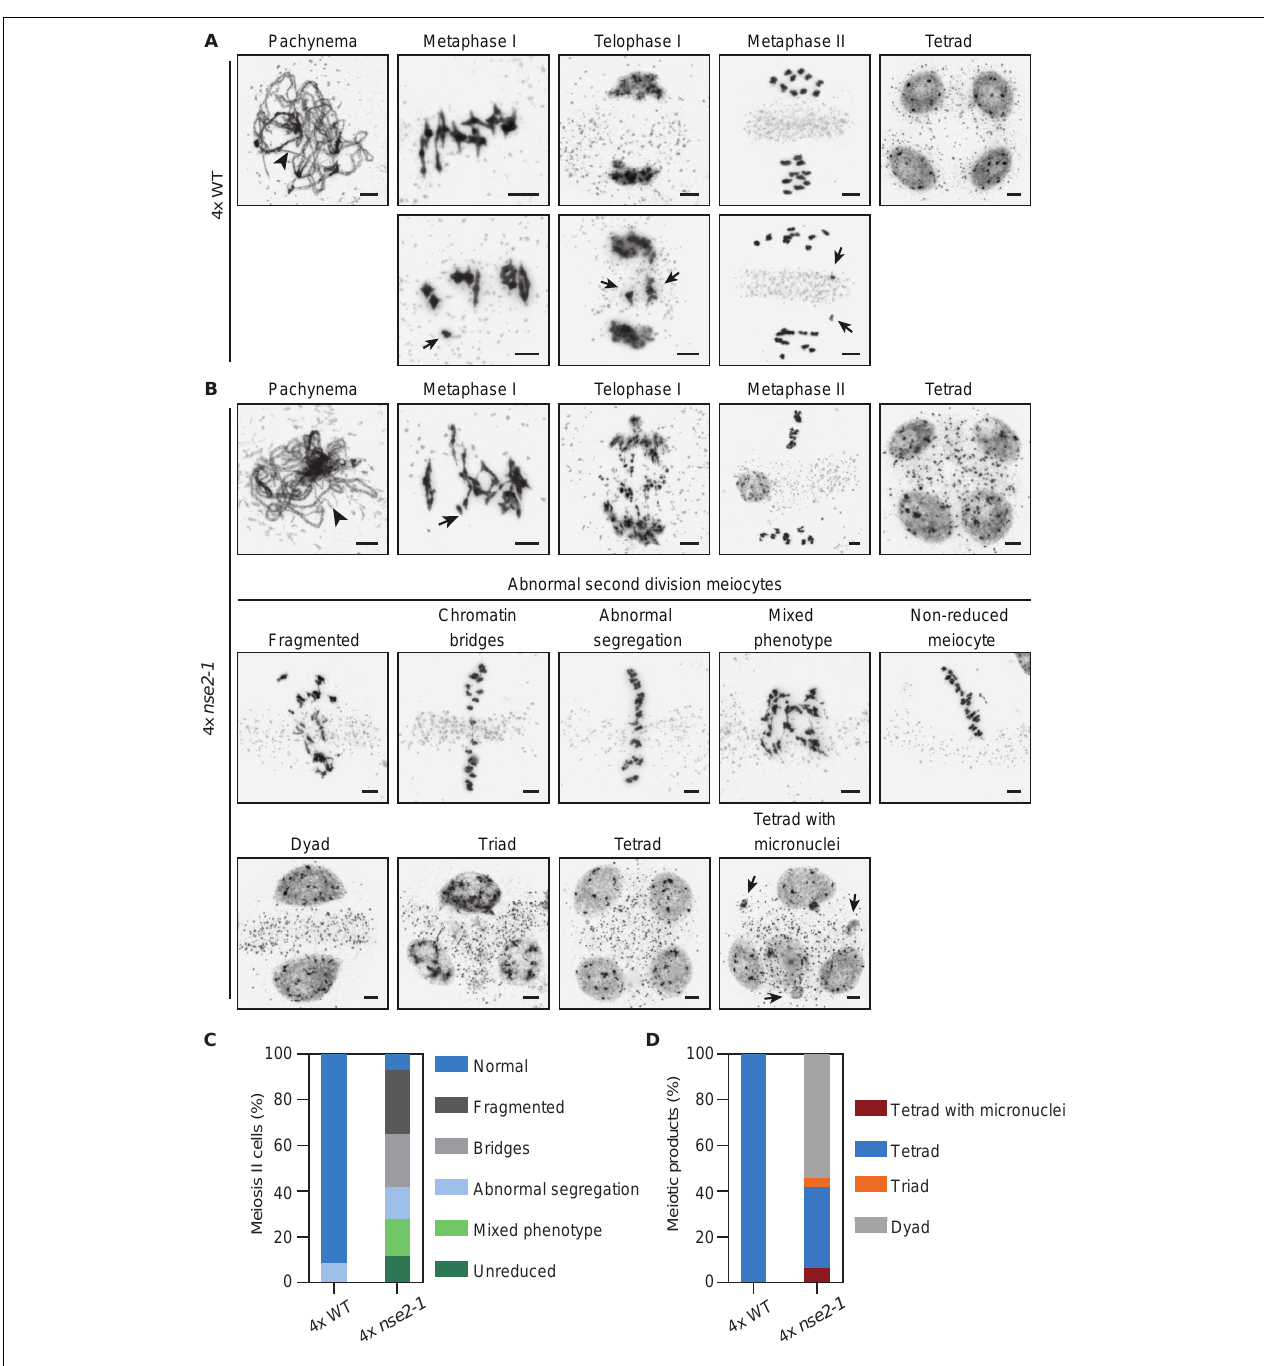
FIGURE 5 | Analysis of male meiosis in 4x nse2-1 plants. (A) Representative images of selected meiotic stages in 4x WT plants. Top row: Unsynapsed regions are detected in pachynema (arrowhead). At metaphase I, the chromosome associations are mostly bivalents and quadrivalents. In most meiocytes, chromosome segregation is correct, both in the first and second meiotic division, resulting in the formation of tetrads with balanced nuclei. Bottom row: Examples of metaphase I with a univalent, telophase I with a delay in chromosome segregation, and a metaphase II with chromatids resulting from the equational segregation of anaphase I univalent. (B) Representative images of the phenotype observed in 4x nse2-1 plants. As well as in WT plants, there were some unsynapsed regions at pachynema (arrowhead). At metaphase I, an increase in the frequency of univalents (arrow) was detected with respect to the WT. Complex entanglements were also frequent at this stage. Telophases I displayed a high frequency of chromosome fragments. Meiotic problems were also evident during the second meiotic division in almost all cells analyzed, including chromosome fragmentation, chromatin bridges and/or abnormal chromosome segregation, and non-reduced meiocytes. At the end of the meiotic division, dyads, triads, tetrads, and tetrads with micronuclei were formed (bottom row). See the text for more details. Scale bars = 5 µ m. (C) Quantification of the different phenotype observed in 4x nse2-1 plants during second meiotic division. (D) Quantification of division products at the end of meiosis. Note: The data for 2x WT and 2x nse2 plants were published previously (Yang et al., 2021; Figures 3 , 4 ).